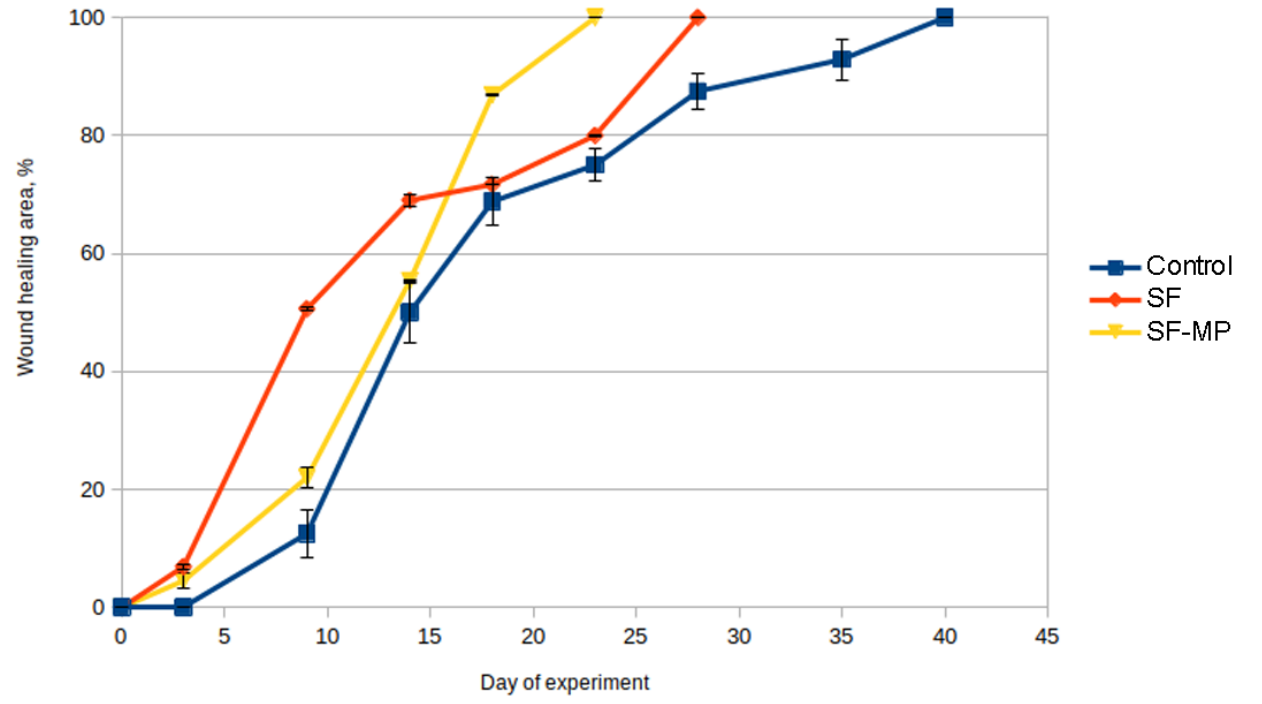
Figure 12. Wistar rat skin healing curves. After complete wound healing on the aforementioned days of the experiment for each group, sections of skin tissue samples from the wound areas were collected from all three groups, stained with Masson’s trichrome, and studied by optical microscope. Thus, we compared completely regenerated skin tissue in the control group on day 40 with samples of regenerated skin tissues from the experimental groups from considerably earlier periods to prove the observed acceleration of full skin regeneration in the experimental groups by histology means. A histological evaluation of skin samples in the area of complete wound healing for each group (A = 100%) revealed the restoration of three layers of skin in all the experimental animals—epidermis, dermis, and hypodermis—which indicated successful wound healing (Figure 13). Moreover, as seen in Figure 13C, a hair follicle was observed, which also indicated a complete functional restoration of the skin. Figure 13B reveals a thicker stratum corneum of the epidermis and a friable structure of the dermis. A looser structure of the dermis relative to the control was also observed on histological sections of samples of group